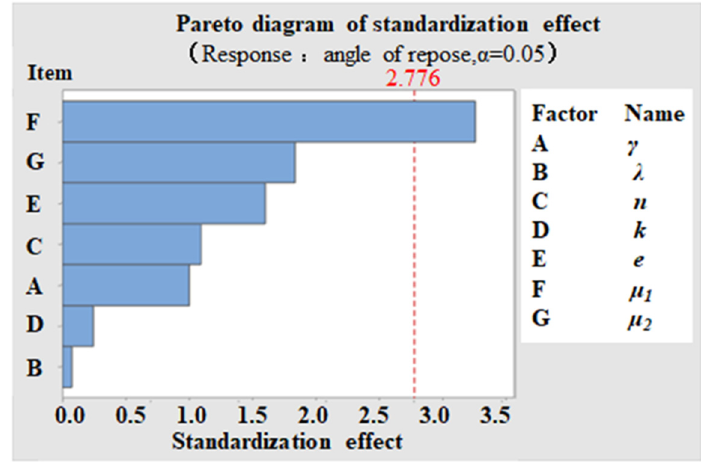
Figure 14. Pareto diagram of standardization effect of PBD test.